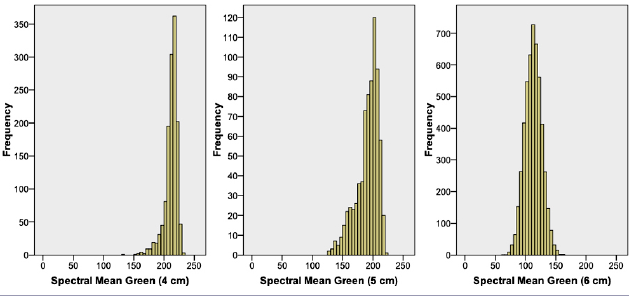
Fig. 8 . Frequency histograms showing the distribution of values for the “spectral mean” attribute in the green band among manually identified Lesser Snow Geese ( Chen caerulescens caerulescens ) in 4-cm (n = 1335), 5-cm (n = 744), and 6-cm (n = 5024) resolution aerial imagery. Geese appear considerably darker in the 6-cm imagery compared to the 4- and 5-cm